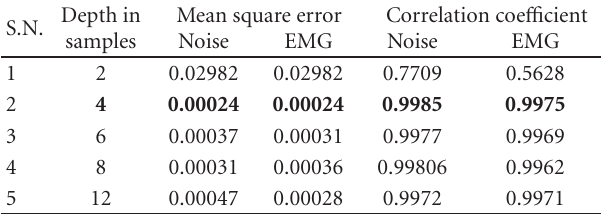
Table 7: Selection of depth of samples for optimal performance of FTLRNN model.